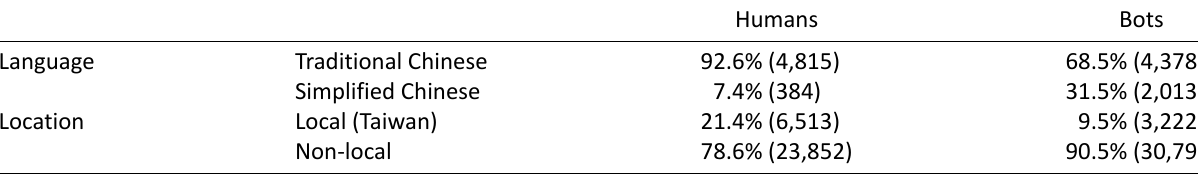
Table 4. Proportion of simplified vs. traditional Chinese tweets and the location of